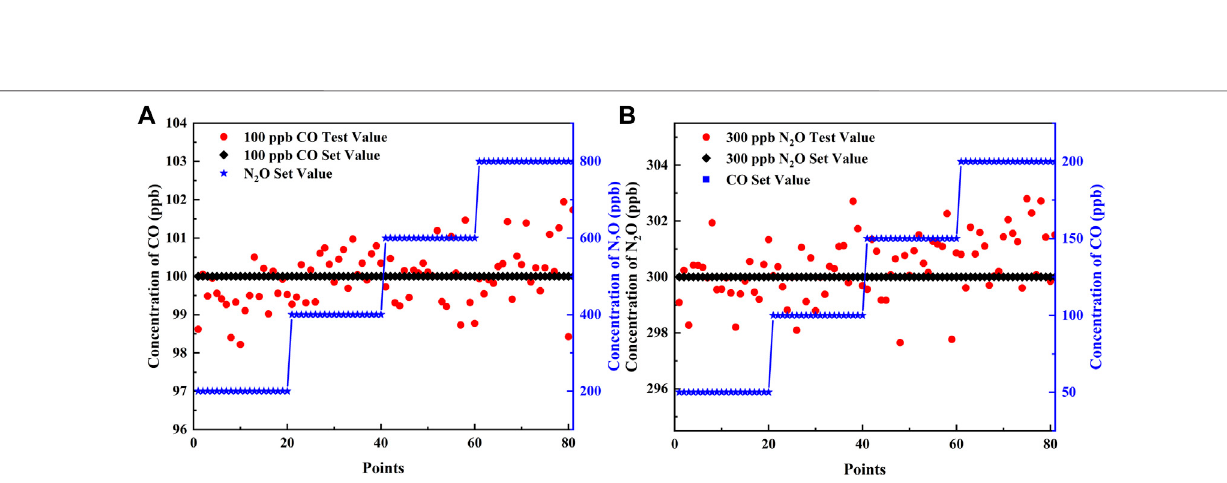
Frontiers in Chemistry |